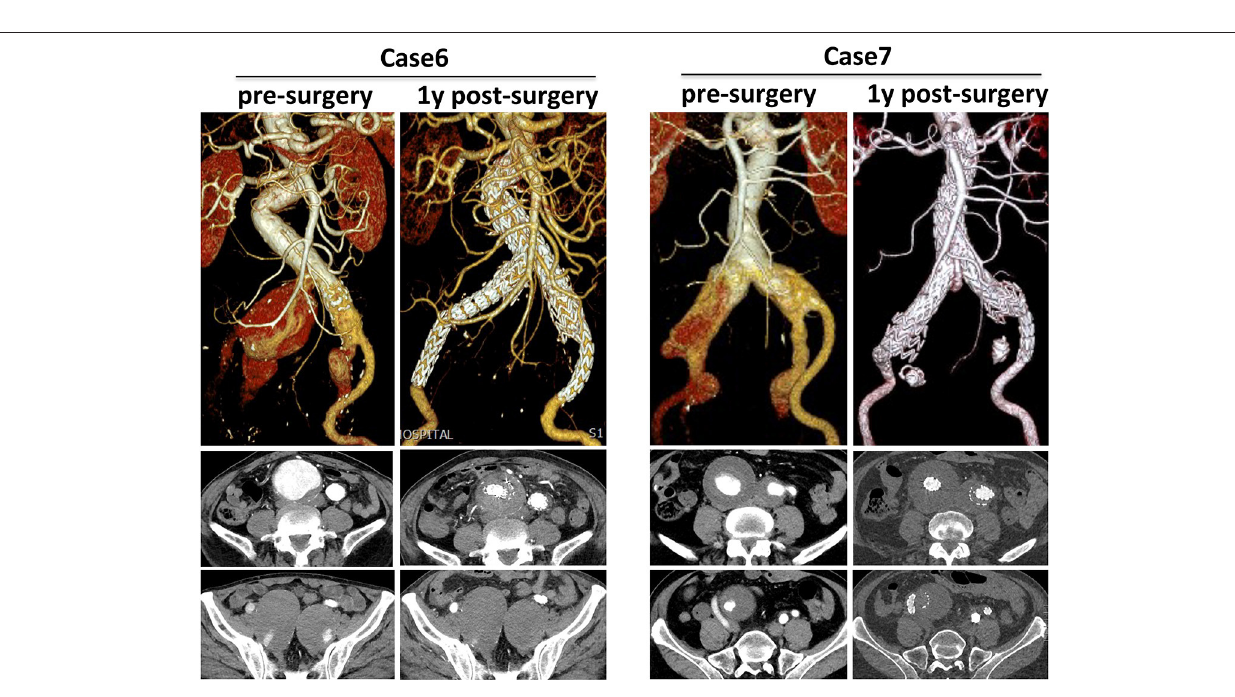
FIGURE 4 | Different strategies in treating IIAA in CST group. 3D CTA pre-surgery and 1-year post-surgery was compared and corresponding transverse section was also